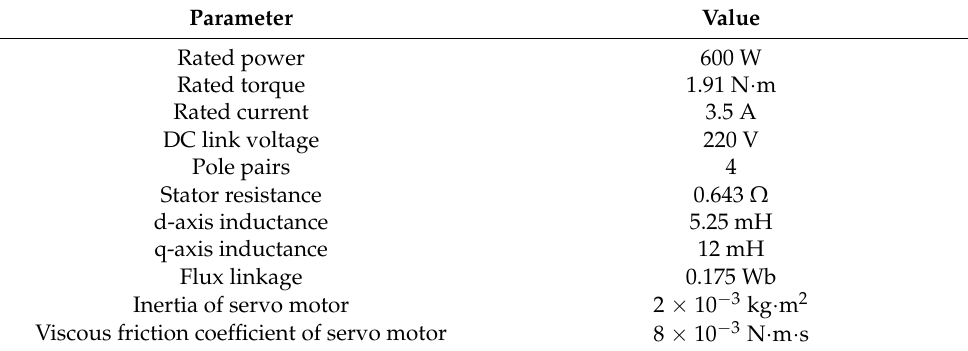
Table 1. Main parameters of the servo controller